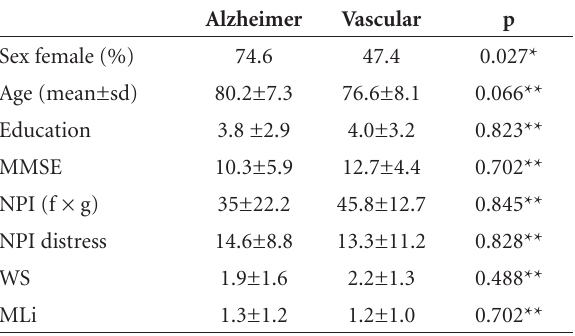
Table 2. Comparison of demographic and clinical data between AD and VaD patients.